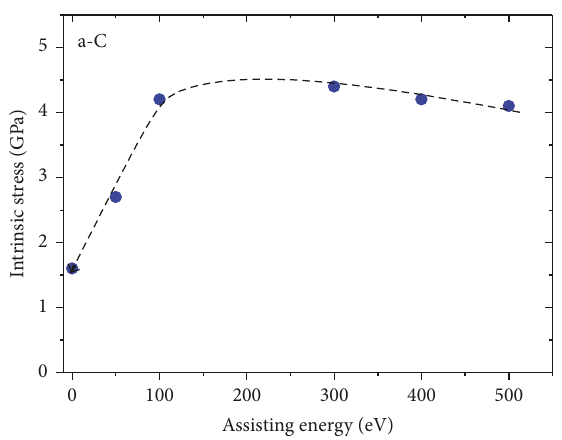
Figure 1: Compressive intrinsic stress as a function of the bombard- ment energy (assisting energy) with Ar + ions. The dashed line is a guide to the